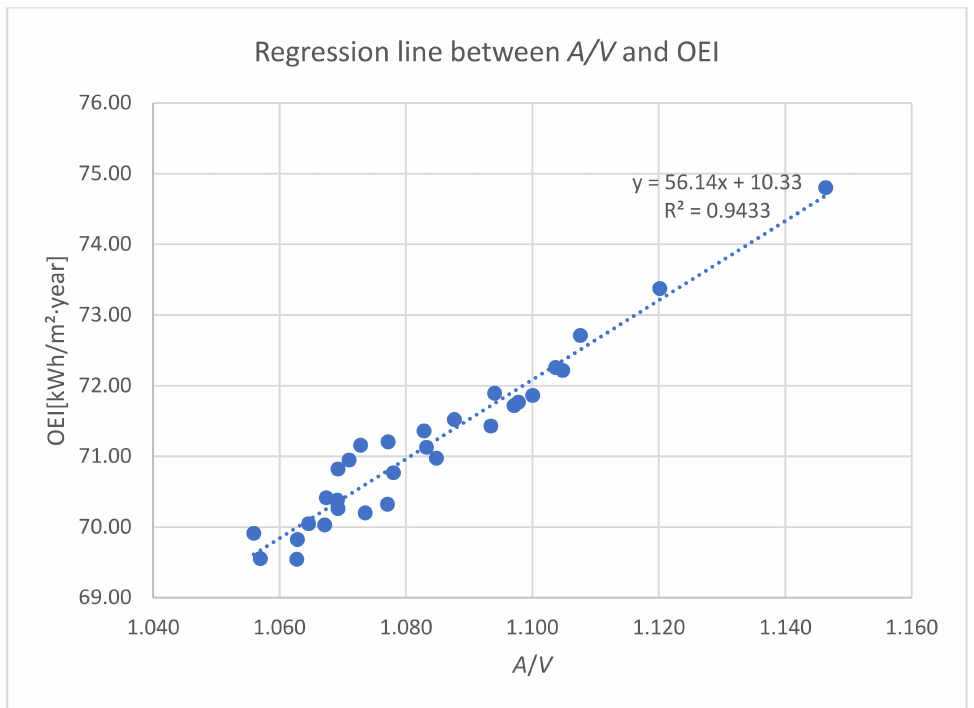
Figure 3. High degree of regression line fit as an approximation of the linear dependence of the OEI dependent variable on the independent A / V variable.